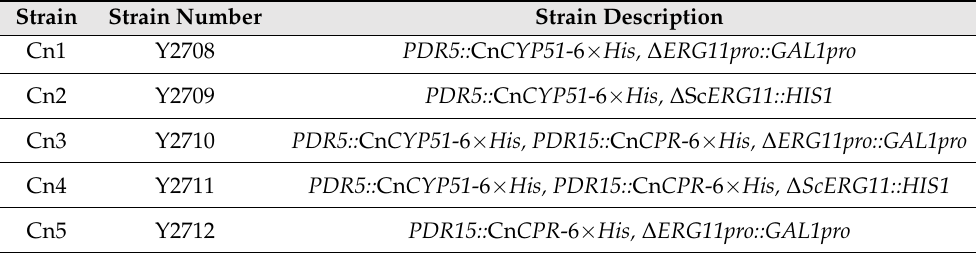
Table 1. Strains constructed in the